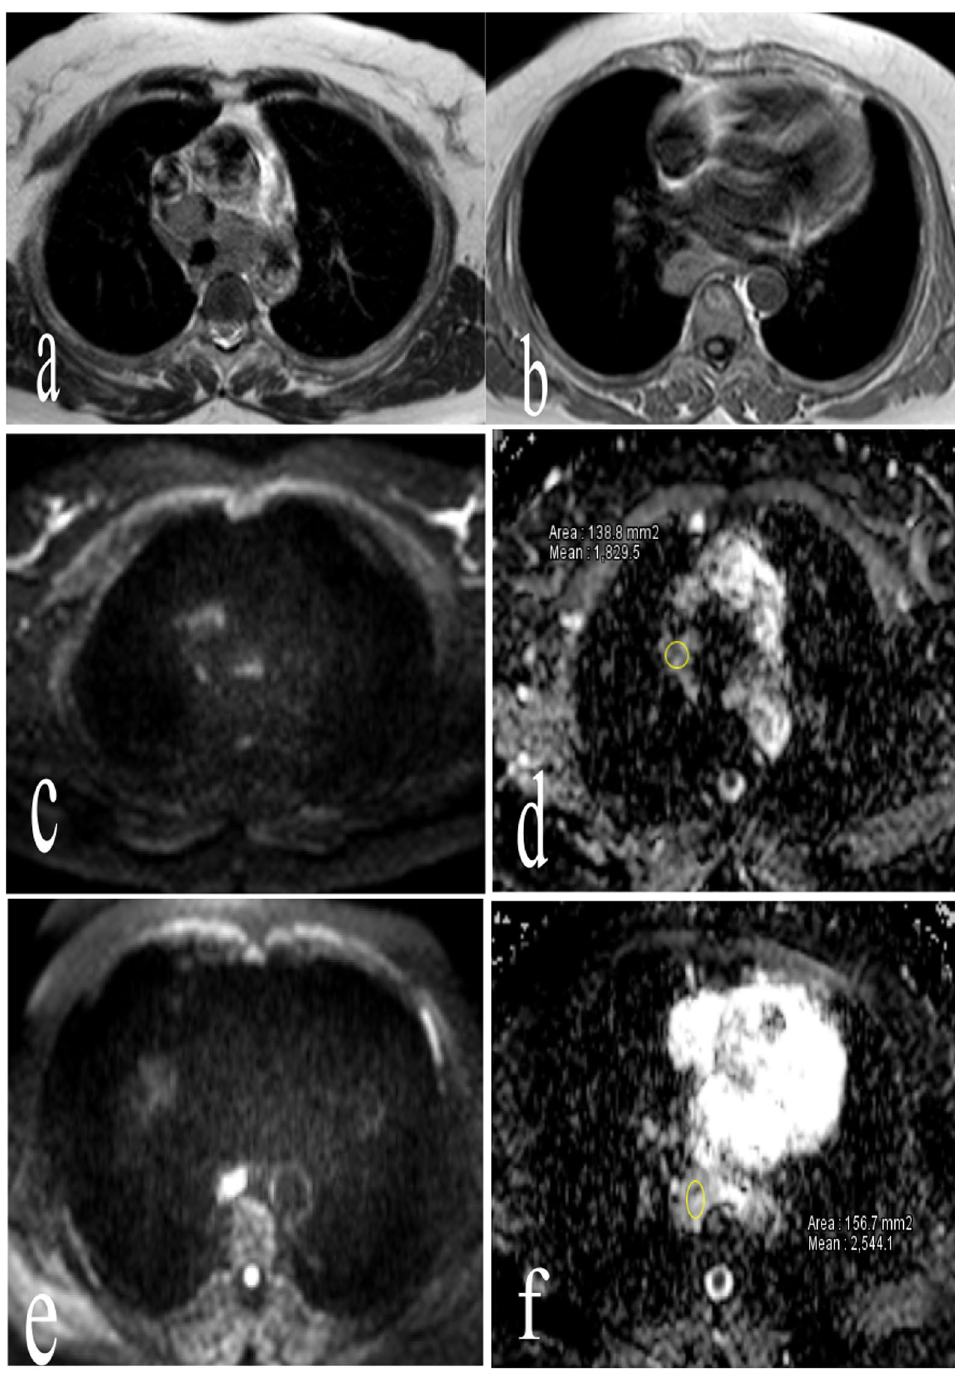
Fig. 4 a Axial T2WI, b axial T1WI, c , e diffusion-weighted MRI image, d , f ADC map showing paratracheal, retrocaval, aortopulmonary, paraesophygeal and small bilateral hilar lymph nodes which are isointense on T1WI, iso to hyperintense on T2 WI, hyperintense on DWI and faintly hyperintense ADC map with mean ADC value of 2.1 10 − 3 mm 2 ×